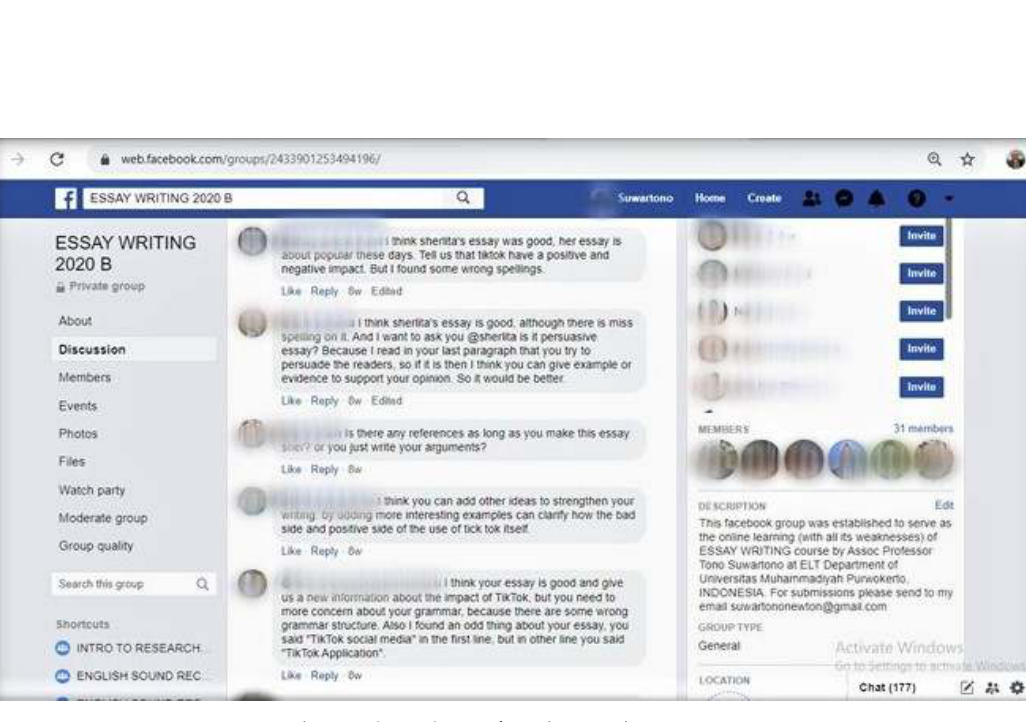
Figure 2. A Sample Discussion